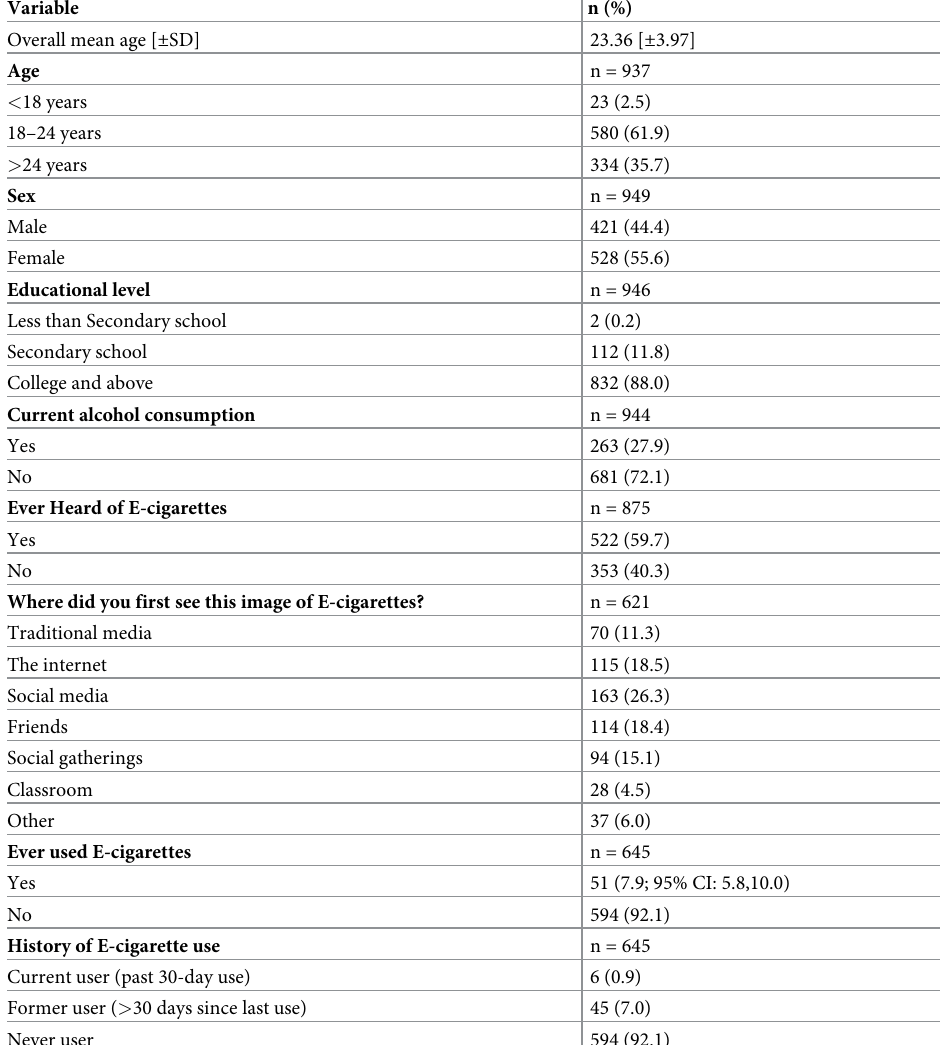
Table 1. Descriptive variables and sociodemographic distribution of